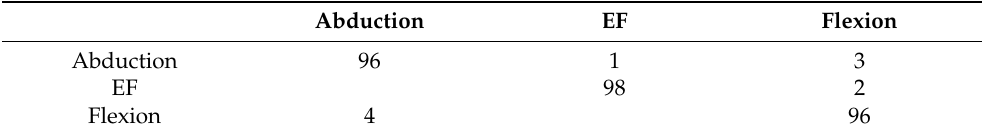
Table 3. Confusion matrix of activity recognition (in %). Rows represent actual exercise, whereas columns show algorithm predictions (cells with value 0 are left